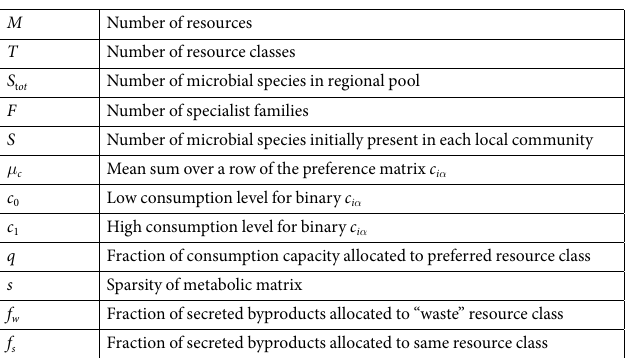
Table 2. Definitions of global parameters used for constructing random ecosystems.